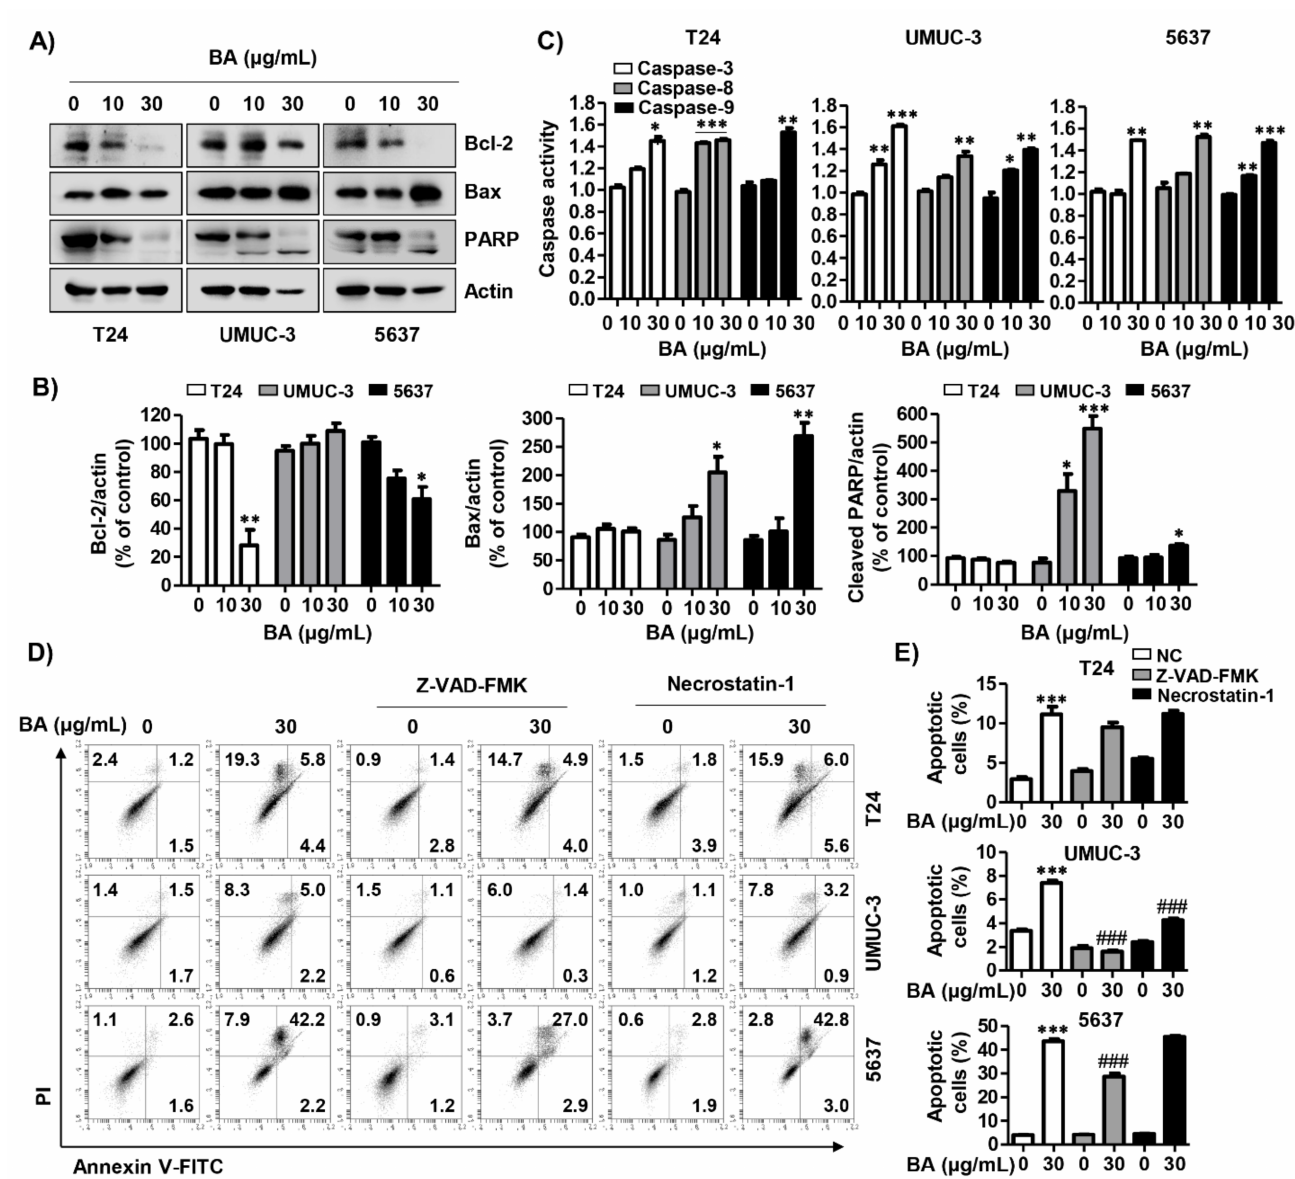
Figure 6. BA-induced apoptosis is associated with caspase activation in human bladder cancer cells. Cells were treated with BA (0, 10, and 30 µ g/mL) for 48 h, and then cells were harvested. ( A ) The expression of mitochondrial-associated apoptotic proteins (Bcl-2 and Bax) and PARP were detected using Western blot analysis. Actin was used as loading control. ( B ) Bar graphs indicate the relative band density in western blot analysis ( n = 3). * p < 0.05, ** p < 0.001, and *** p < 0.0001 vs. untreated control group. ( C ) The activities of caspase-3, -8, and -9 were measured by caspase colorimetric assay kits. Each bar represents the mean ± SD of three independent experiments. * p < 0.05, ** p < 0.001, and *** p < 0.0001 vs. untreated control group. ( D ) Cells were pre-treated with or without benzyloxycarbonyl-Val-Ala-Asp (OMe) fluoromethylketone (Z-VAD-FMK), which is pan-caspase inhibitor, or necrostatin-1, which is necrosis inhibitor, for 1 h, and then cells were treated with BA (0 and 30 µ g/mL) for 48 h. Cells were collected, stained with annexin V-FITC/PI, and then apoptotic cells (annexin V + ) and necrotic cells (PI + ) were analyzed using flow cytometry. ( E ) The changed the proportion of apoptotic cells by treatments were quantified. Data are expressed as the mean ± SD ( n = 3). *** p < 0.0001 vs. untreated control group and ### p < 0.0001 vs. BA-treated